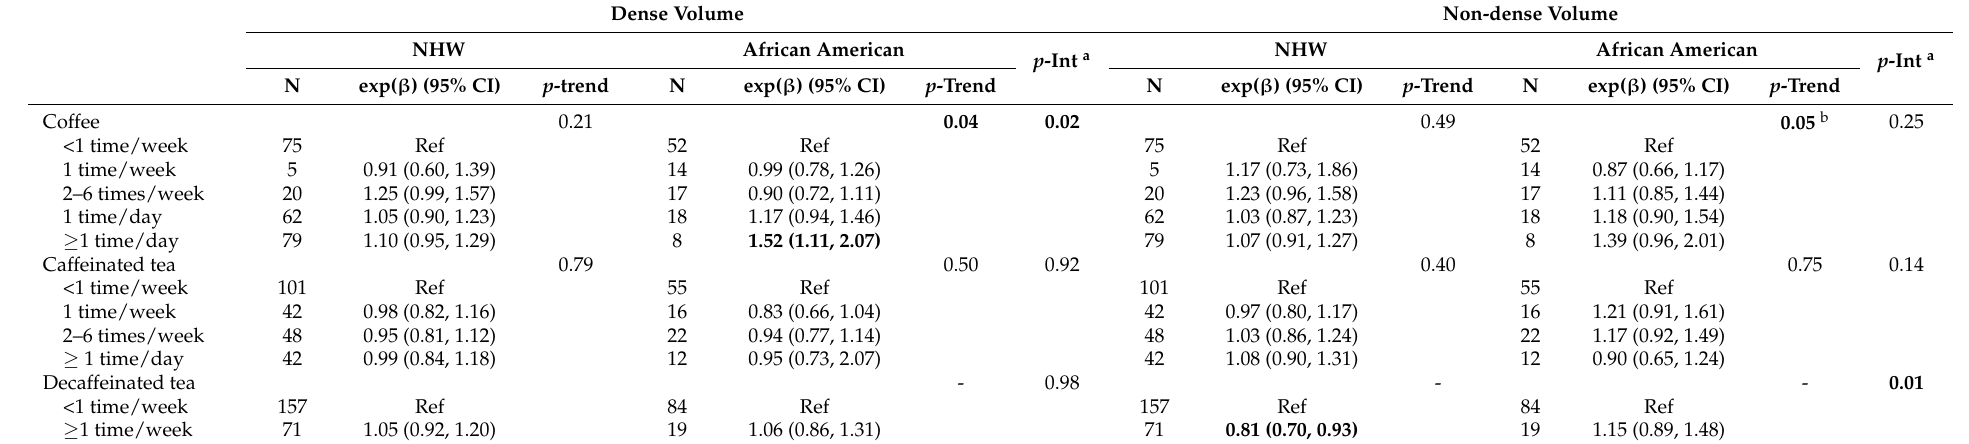
Table 5. Associations of coffee/tea intake with dense volume and non-dense volume stratified by race *. Dense Volume Non-dense Volume NHW African American African American